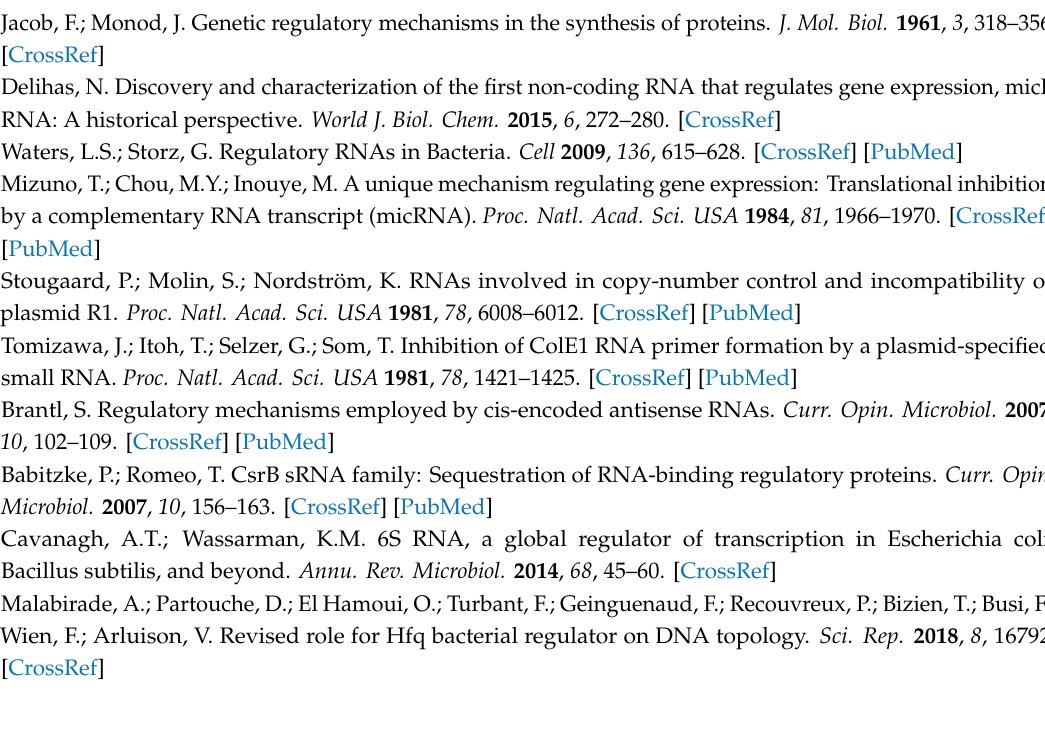
Funding: This work and the article processing charge (APC) were funded by the Natural Sciences and Engineering Research Council of Canada (NSERC) Discovery Grant number